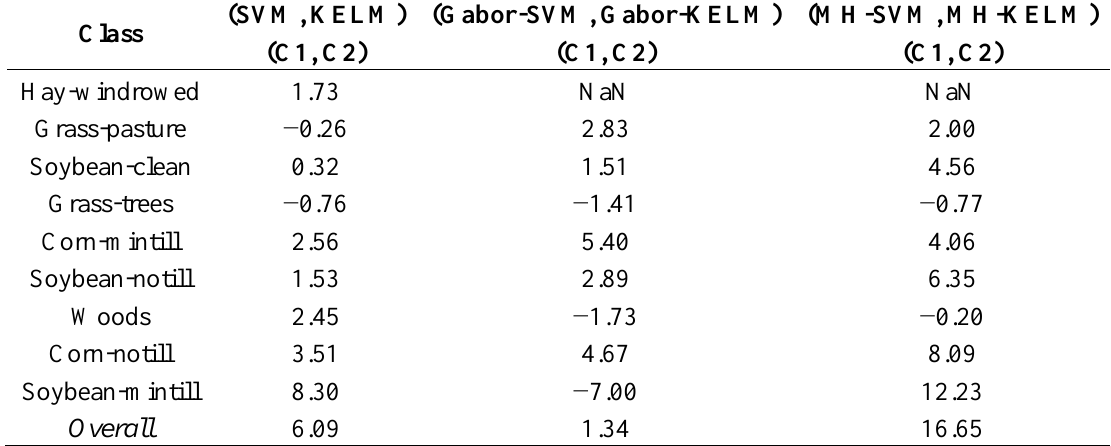
Table 6. McNemar’s test ( Z ) for the Indian Pines dataset (nine classes, 20 samples per class for training).